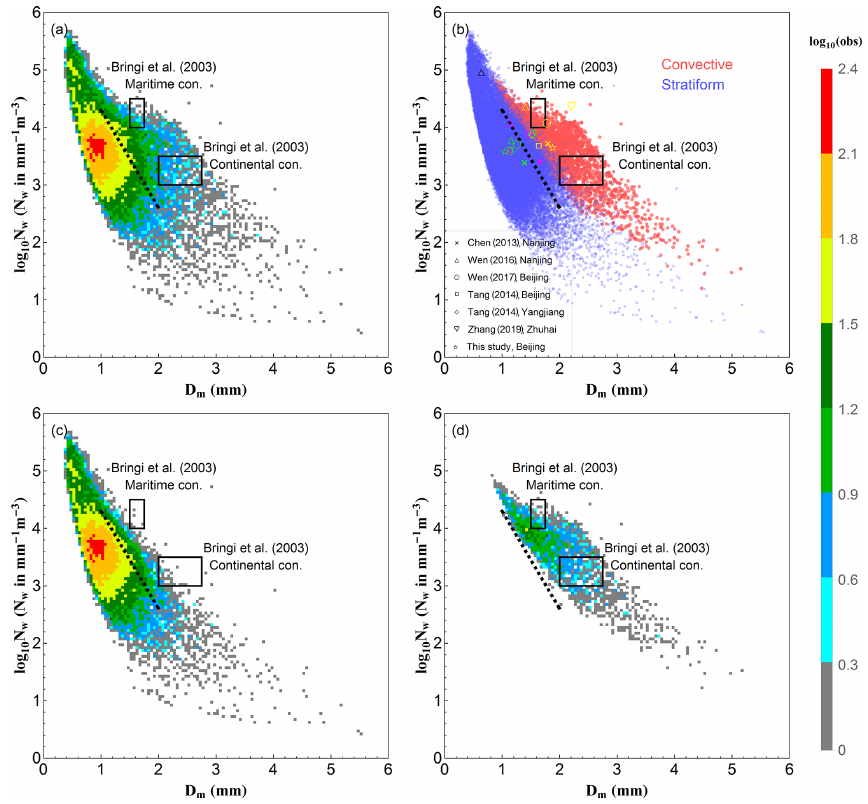
Figure 5. Scatter density plot of log 10 N w versus D m : (a) the total rainfall events; (c) stratiform events; (d) convective events. (b) is the scatterplot of log 10 N w versus D m for the convective (red circle dots) and stratiform (blue square dots) cases. The two black rectangles in each subplot correspond to the maritime and continental convective clusters, and the black dashed line is the log 10 N w – D m relationship for stratiform rain reported by Bringi et al. (2003). The cross, hollow triangles, circle, squares, diamonds, and hearts in (b) represent the averaged values obtained in previous studies by Chen et al. (2013), Wen et al. (2016), G. Wen et al. (2017), Tang et al. (2014), and A. S. Zhang et al. (2019) for different parts of China. The colors of these symbols represent different events: magenta for total rainfall events; green for convective events; yellow for stratiform events; and black for the shallow events, a third type of precipitation besides convective and stratiform suggested by a few researchers, based on data from vertically pointing radar observations (Fabry and Zawadzki, 1995; Cha et al., 2009) in the study by Wen et al. (2016). Table 2. Statistical properties of DSD parameters for convective and stratiform